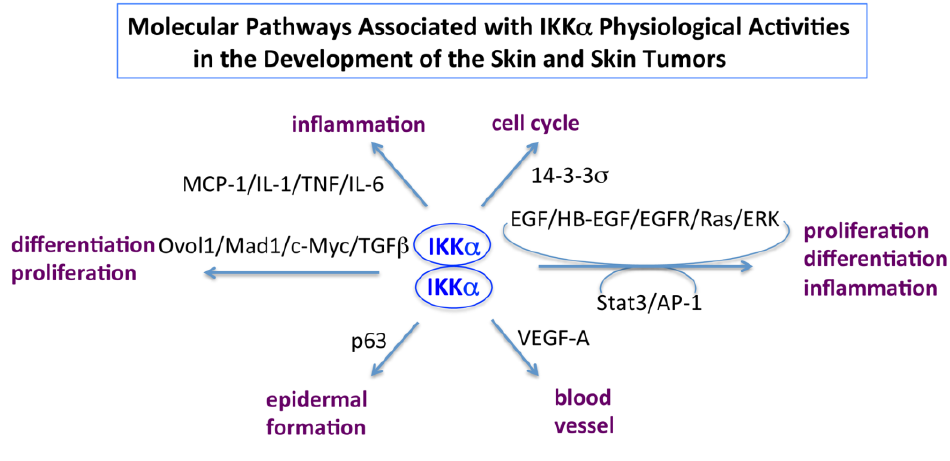
Figure 2. Identified pathways associated with IKK  functions in the skin and skin tumor development in mice. Arrows indicate IKK 